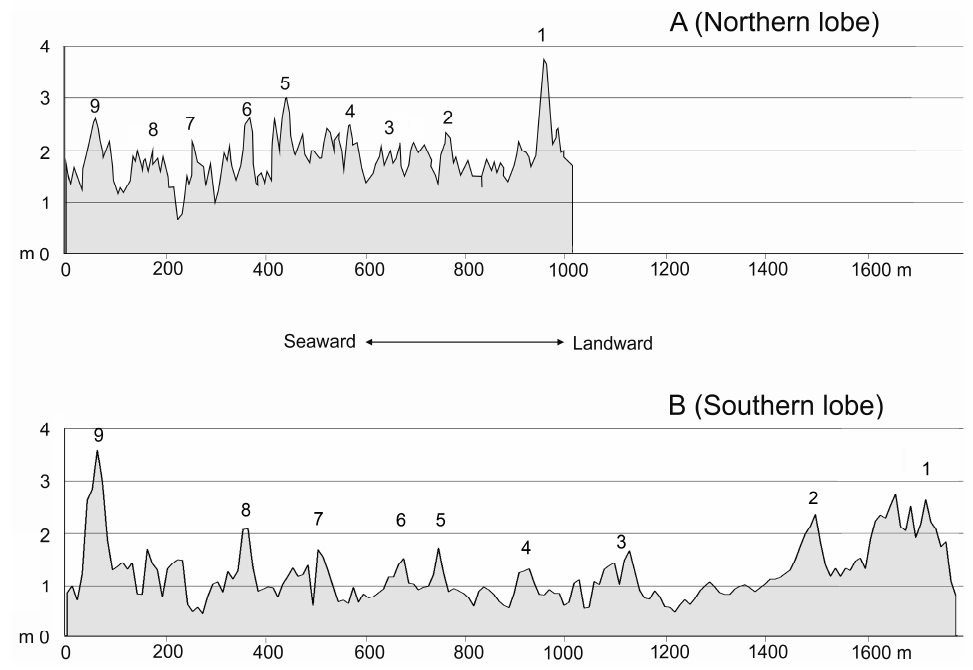
Figure 2. Ombrone River delta, beach ridges pattern mapped through the combination of different data sets and elaboration methodologies.